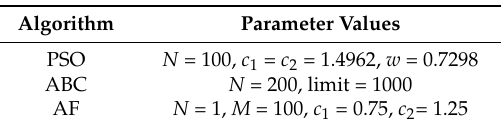
artificial flora (AF)